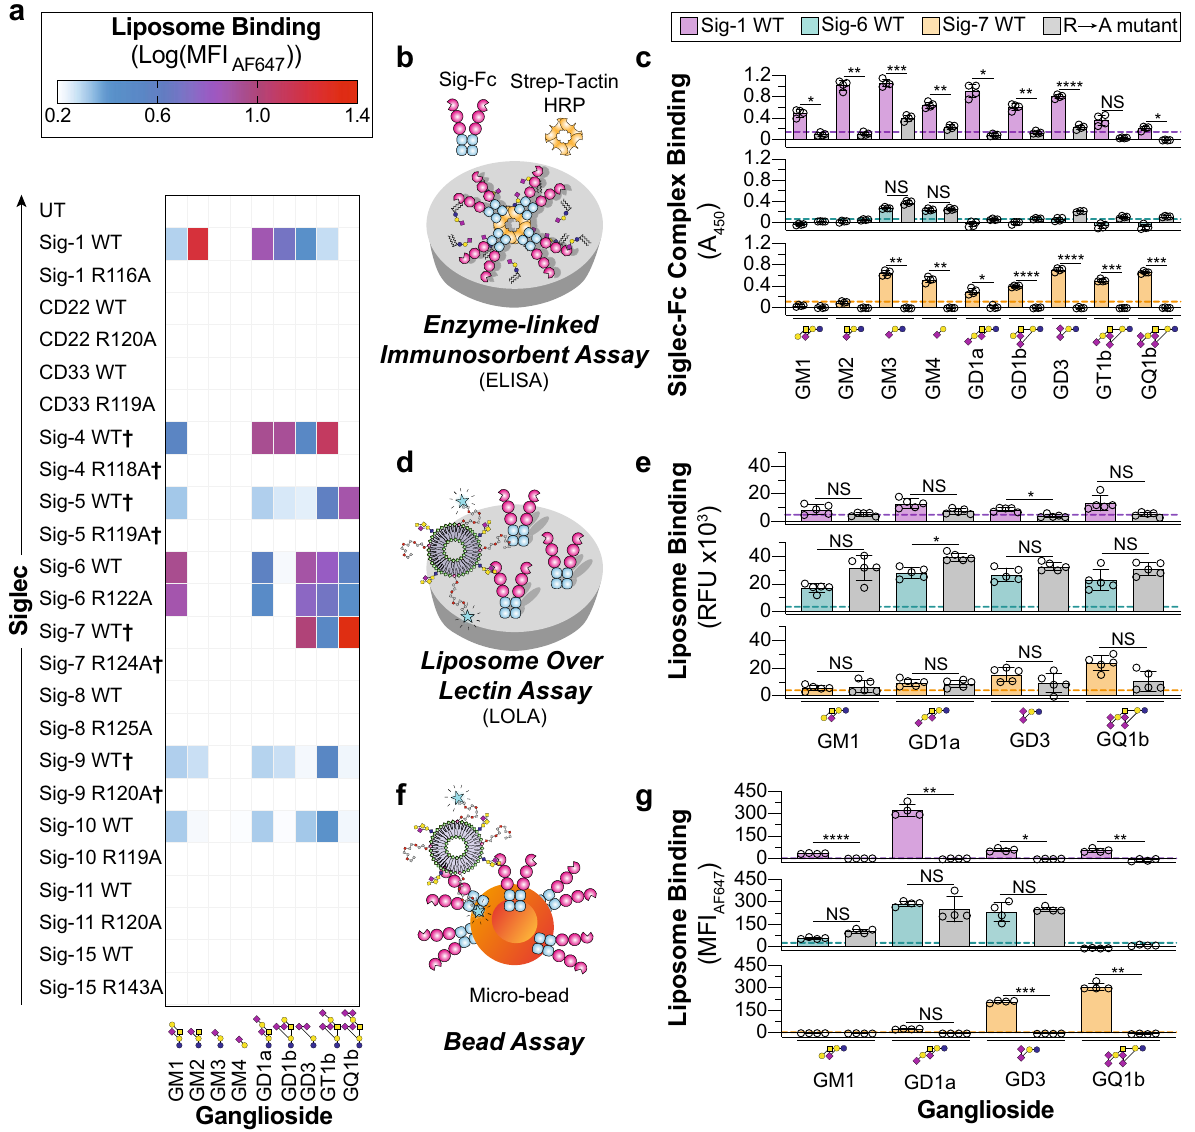
Fig. 2 | Investigating Siglec – ganglioside interactions using optimized lipo- somes reveals interactions. a Heatmap summarizing the binding interactions of each human Siglec (4 ≥ n ≥ 3 technical replicates). Color is representative of the log 10 (MFI AF647 ) of each GLL subtracted from the log 10 (MFI AF647 ) of the same GLL againstUTCHOcells. † Denotesbindingwasmeasuredaftertreatmentofcellswith neuraminidase. b Schematic of the enzyme-linked immunosorbent assay (ELISA) used to investigate Siglec – ganglioside interactions outside the context of a lipid bilayer. c ELISA results of Siglec-1, -6, and -7 binding to nine gangliosides ( n =4 technical replicates). d Schematic of the liposome over lectin assay (LOLA) where binding is read out on a fl uorescence plate reader. e Results of the LOLA against a